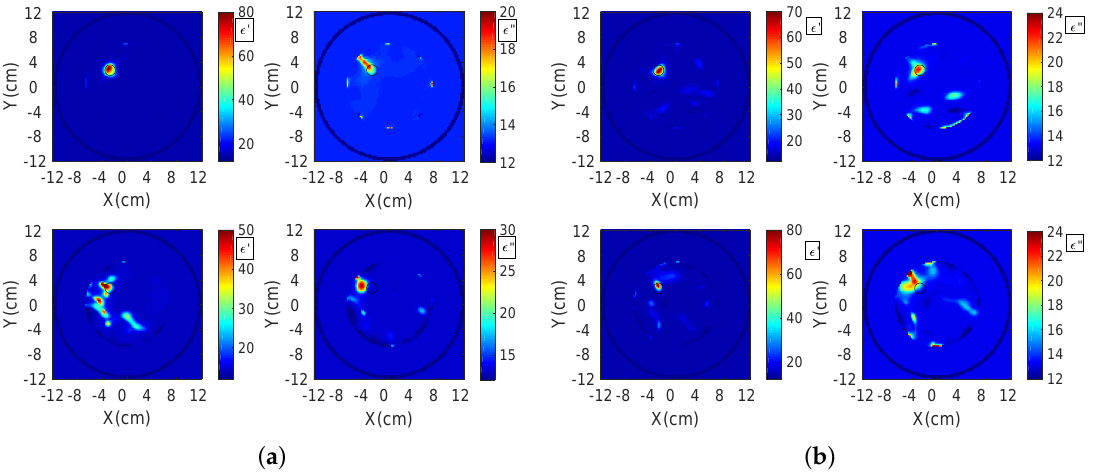
Figure 12. Reconstructed real and imaginary parts of the complex permittivity for the region inside the antenna array of Figure 4 in the presence of: ( a ) water and ( b ) salt–water targets. The top row corresponds to data calculated from CST simulations and the bottom row to data measured from our experimental system. The complex permittivity was calculated at 1.2 GHz from the Debye parameters, which were reconstructed using a frequency hopping approach at 1.2, 1.5, 1.8, 2.1, and 2.4